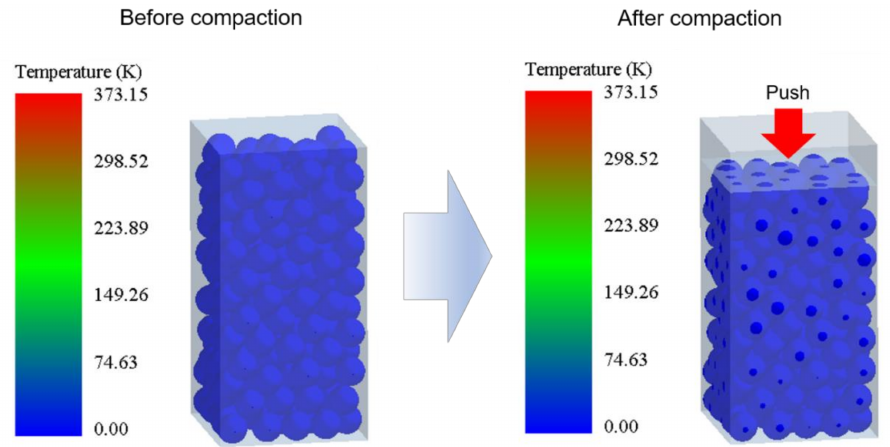
Figure 2. Discrete element method (DEM) modelling for bentonite and graphite mixed particles with bulk dry density of 1.67 g/cm 3 .